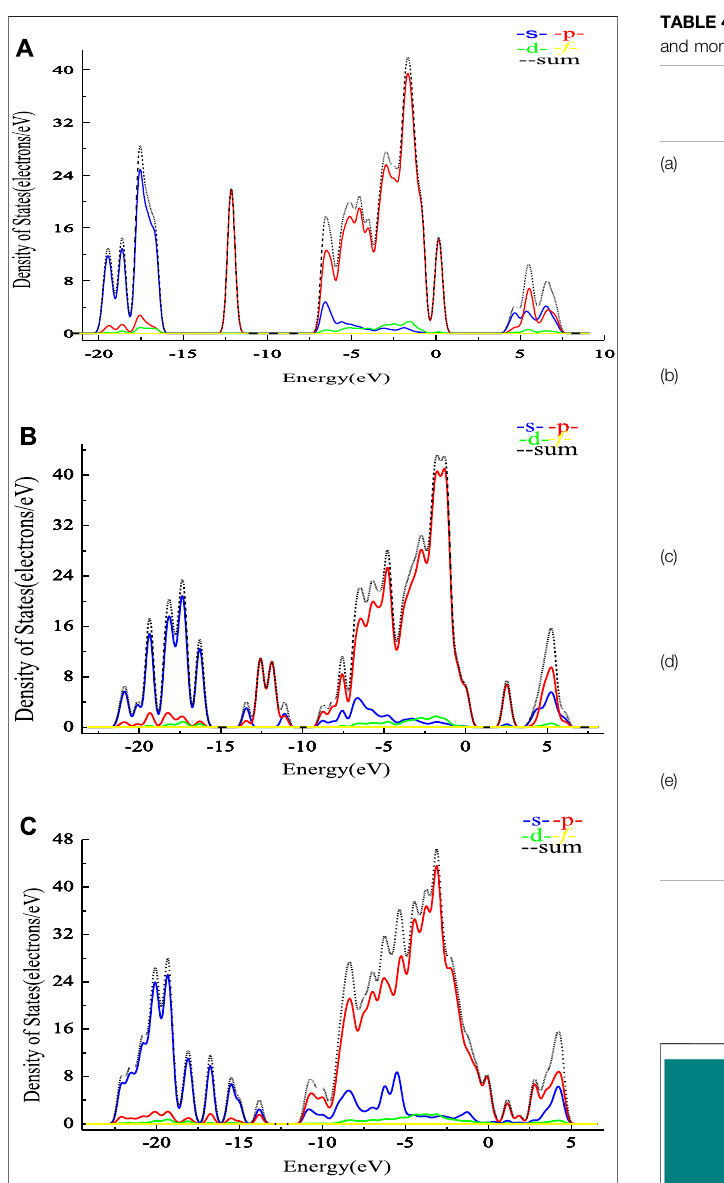
FIGURE 2 | PDOS of different minerals before and after the adsorption. (A) PDOS analysis of the illite (020) surface before adsorption. (B) PDOS analysis between the illite (020) surface and sodium tartrate. (C) PDOS analysis between the montmorillonite (020) surface and sodium tartrate.